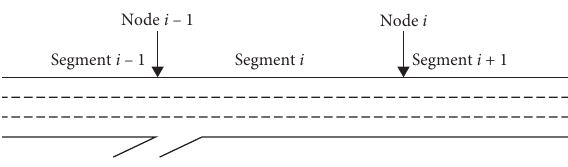
Figure 6: Relationship between segments and